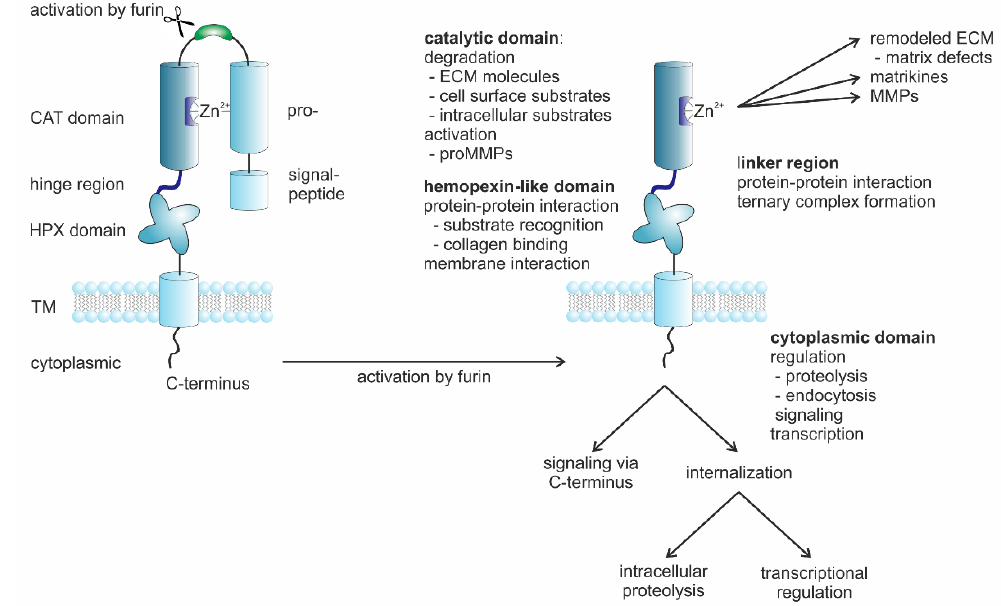
Figure 4. Domain structure of MMP-14 and their functions. MMP-14 is a type I transmembrane matrix-metalloproteinase that decisively determines cancer progression. MMP-14, anchored in the membrane via a C-terminal signal domain, is activated by cleavage of its cysteine-containing propeptide with a furin-like proprotein convertase, as a result of which a zinc ion is activated in its catalytic center. A hemopexin-like (HPX) domain helps in positioning the substrate for cleavage by the catalytic domain and regulates the activity by interaction with the lipid bilayer of the membrane. Its transmembrane (TM) domain and the hemopexin domain support dimerization and continue into a cytoplasmic C-terminal domain that is involved in signaling tasks.